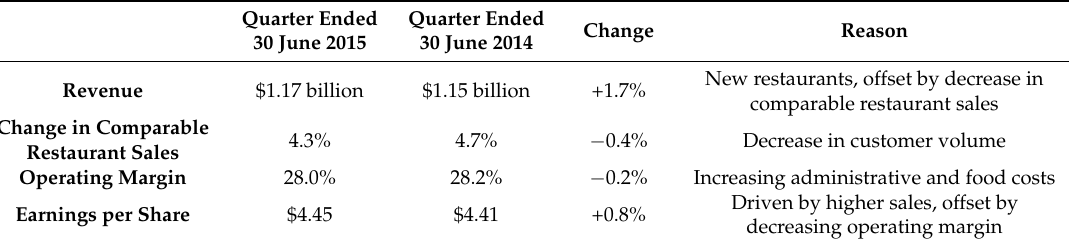
Table A1. Q3 2015 Results Summary for Piri Piri Grill